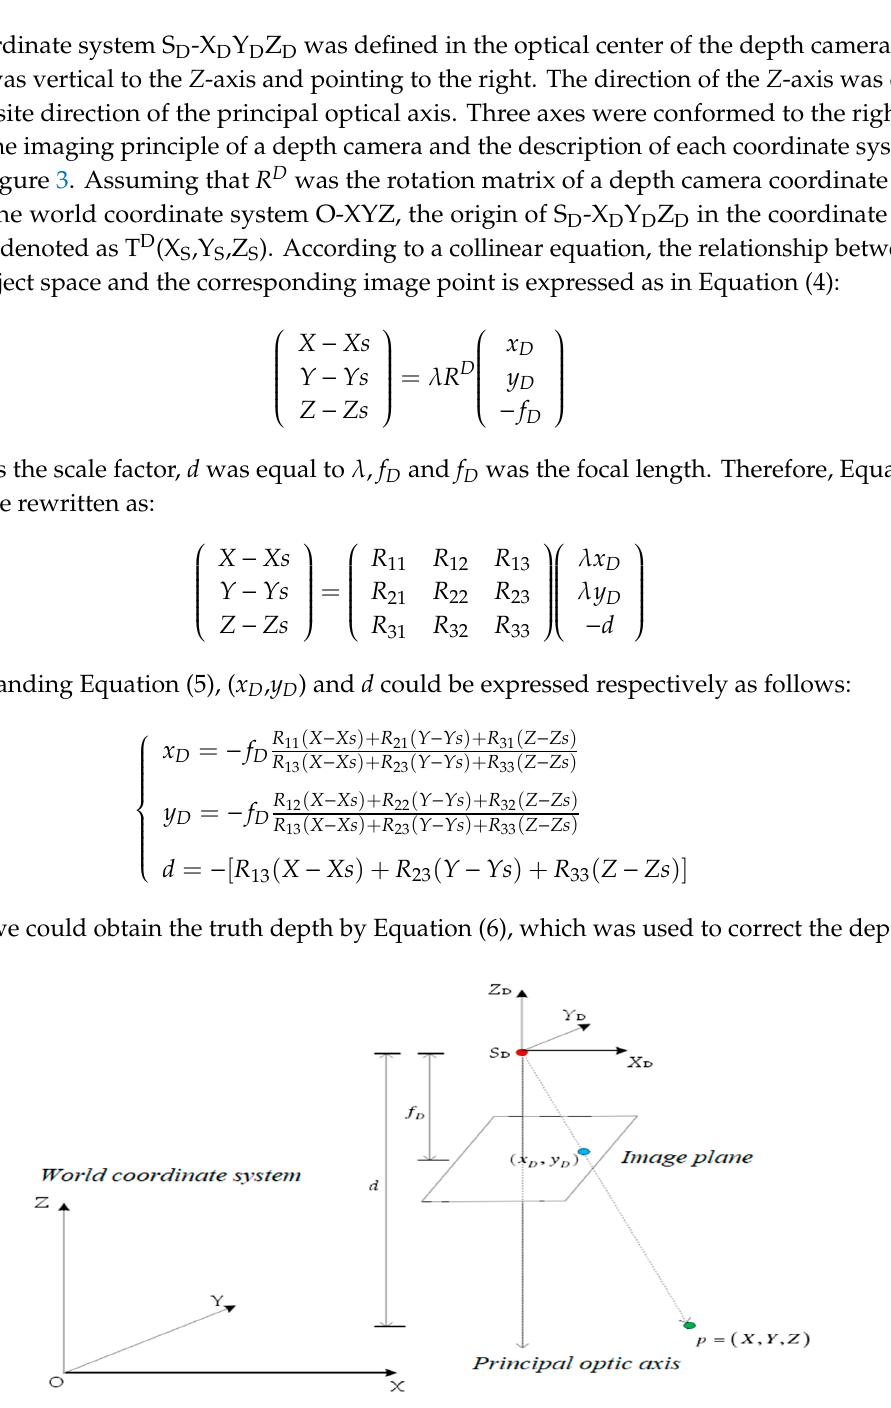
Figure 3. The imaging principle of a depth camera.